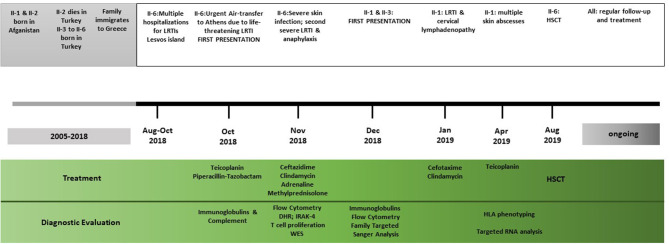
Timeline of the clinical events, diagnostic evaluations, and treatment strategies. LRTI, lower respiratory tract infections; HSCT, haematopoietic stem cell transplant; DHR, dihydrorhodamine flow cytometric test; IRAK, interleukin-1 receptor-associated kinase 4; WES, whole exome sequencing.